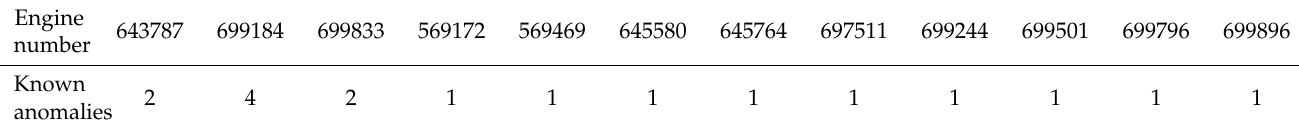
Table 1. Anomaly numbers for each engine.